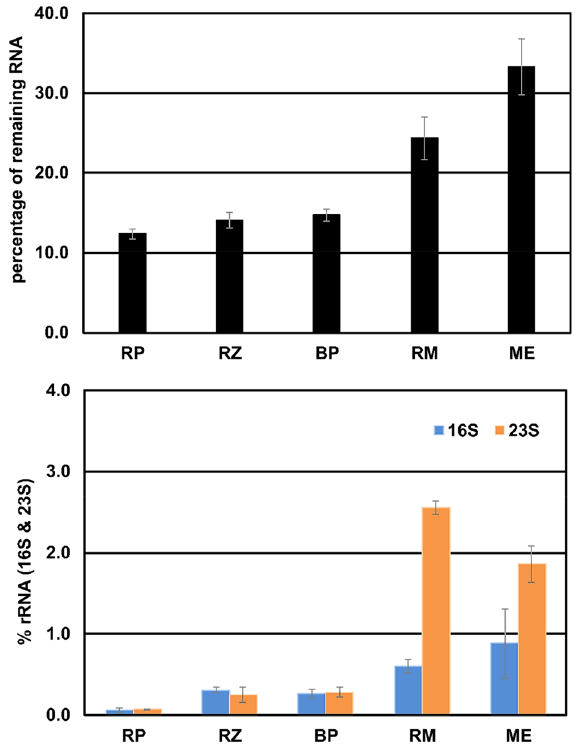
Figure 2. ( A ) Percentage of remaining RNA after depletion using the different depletion kits compared. The input of 2.5 µg total RNA was set to 100%. ( B ) Remaining 16S and 23S rRNA after depletion with the different kits compared to the untreated RNA determined by the Bioanalyzer electropherograms. RP, riboPOOLs; RZ, RiboZero; BP, biotinylated probes; RM, RiboMinus; ME,